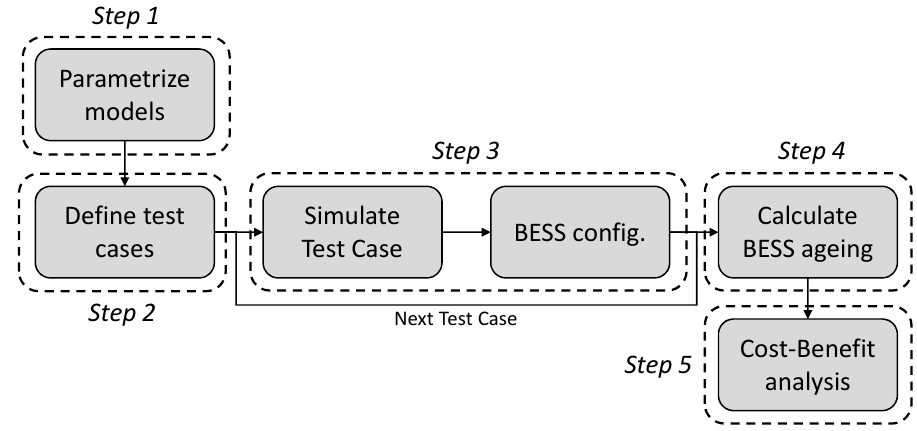
Figure 1. Flow chart of the proposed BESS dimensioning methodology.